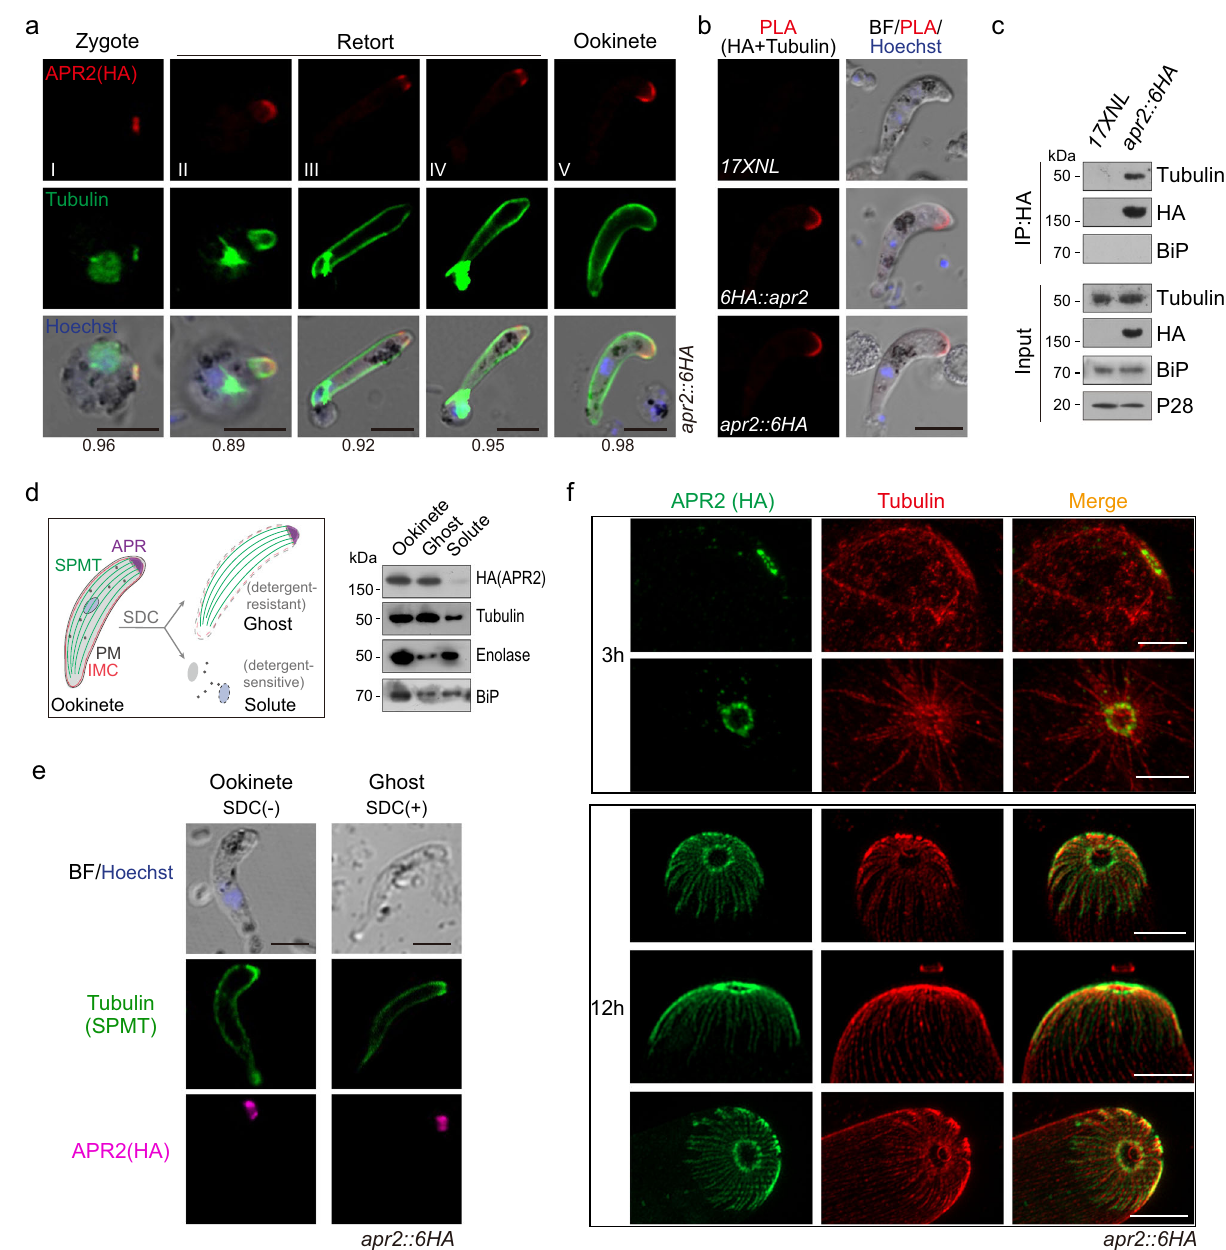
Fig. 3 | APR2 associates with apical subpellicular MTs (SPMTs). a IFA of APR2 (HA, red) and SPMT ( α - and β -Tubulin, green) from zygote (stage I) to ookinete (stage V) development of the apr2::6HA parasite. The values in the bottom are the Pearson correlation coef fi cient for the co-localization between APR2 and apical SPMTs. Three independently performed experiments with similar results. Scale bars: 5 μ m. b Proximity ligation assay (PLA) detecting protein interaction between APR2 and Tubulin in the 6HA::apr2 and apr2::6HA ookinetes. Two independently performed experiments with similar results. Scale bars: 5 μ m. c SPMTs co- immunoprecipitatedwithHA-taggedendogenousAPR2in apr2::6HA ookinetes.Co- immunoprecipitation was conducted using anti-HA antibody. P28 and BiP as the loading control.Representative resultfromtwobiologicalreplicates. d Isolationof ookinete SPMT cytoskeleton (ookinete ghost). Left panel indicated the work- fl ow.